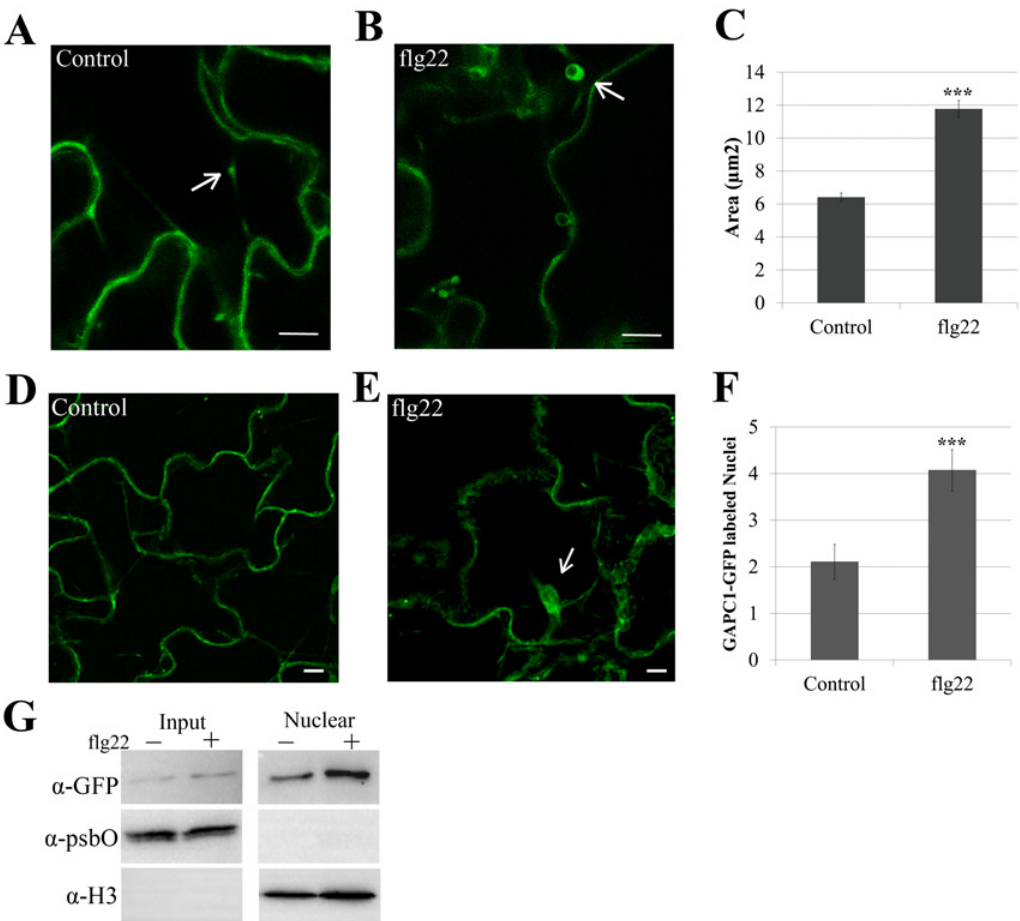
Fig 7. Treatment with flg22 induces an increase in size of GAPC1-GFP labeled vesicles and enhances GAPC1-GFP nuclear localization. Confocal micrographs of the gapc1 KO complemented with npro :: GAPC1-GFP (line 3 – 4) show optical sections of leaves from four-week-old plants ± flg22. (A) Leaves were infiltrated with a needleless syringe with 10mM MgCl 2 and imaged after 30 min. Arrows indicate representative vesicles. (B) Leaves were infiltrated with 5 μ M of the elicitor flg22 and imaged after 30 min. Arrows indicate representative vesicles. (C) Images were quantified using ImageJ to calculate the